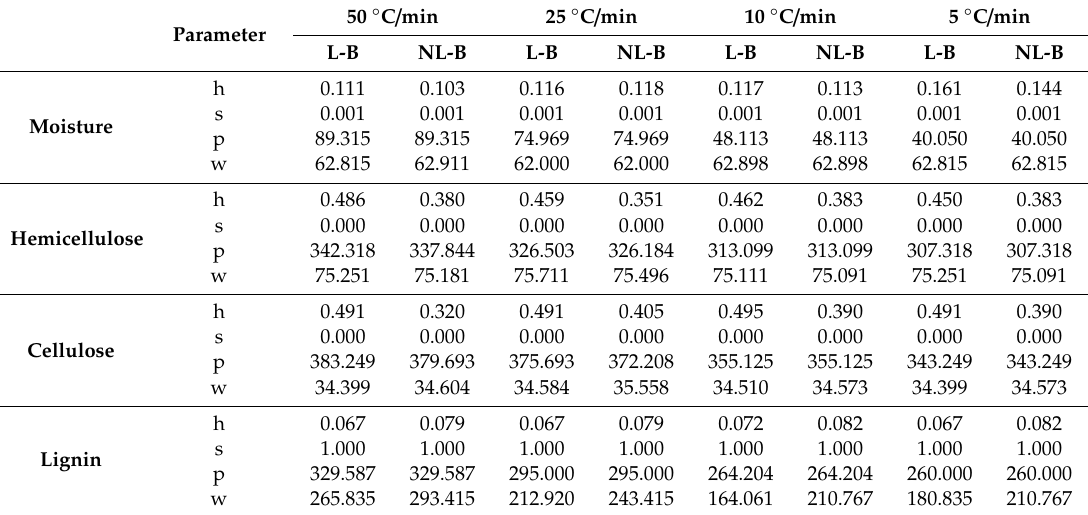
Table 3. Deconvolution parameters of each pseudo-component for both samples.